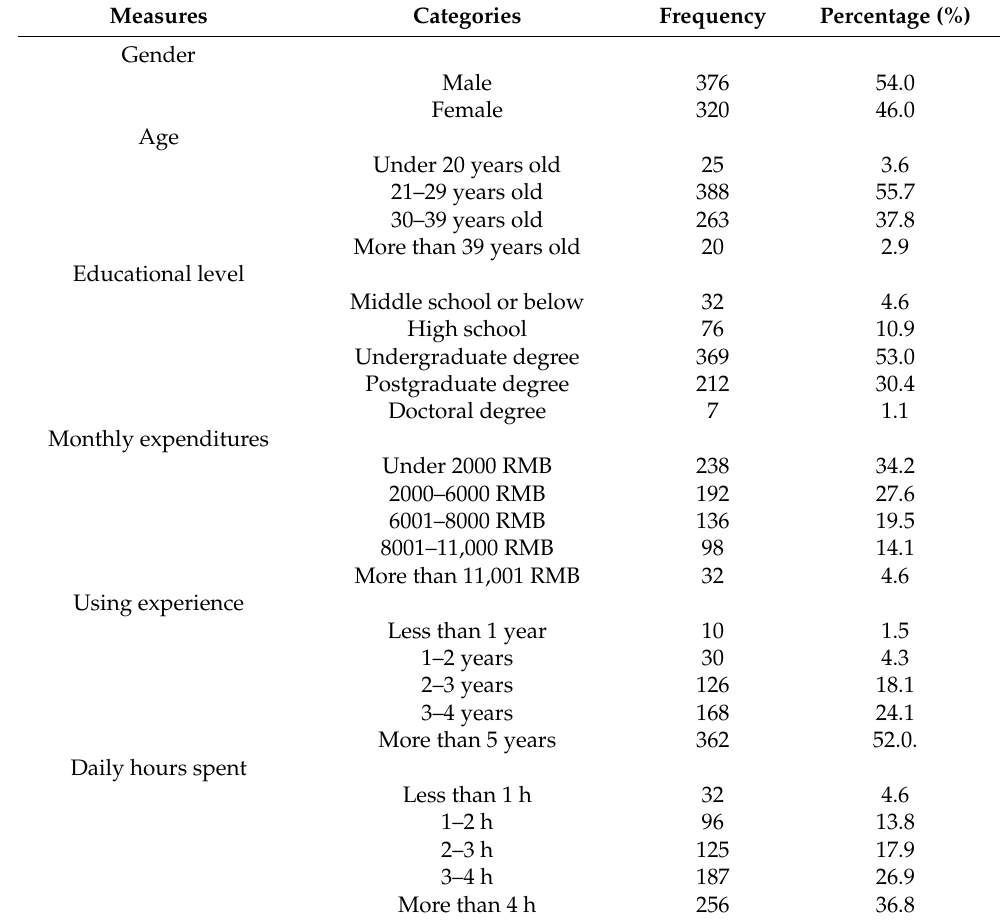
Table 1. Summary of participants’ demographics (n =